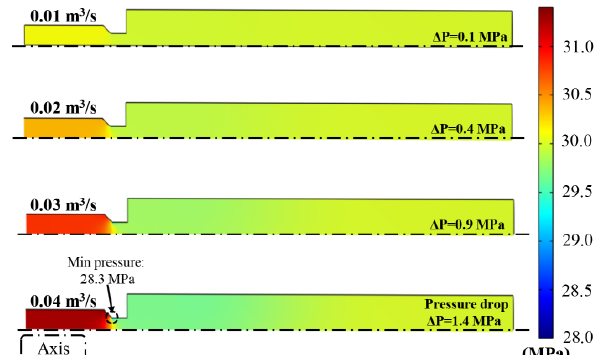
Figure 8. Pressure contours in the differential motion assembly with different inlet flow rates (0.01~0.04 m 3 /s); the fluid viscosity was set as 100 mPa·s.